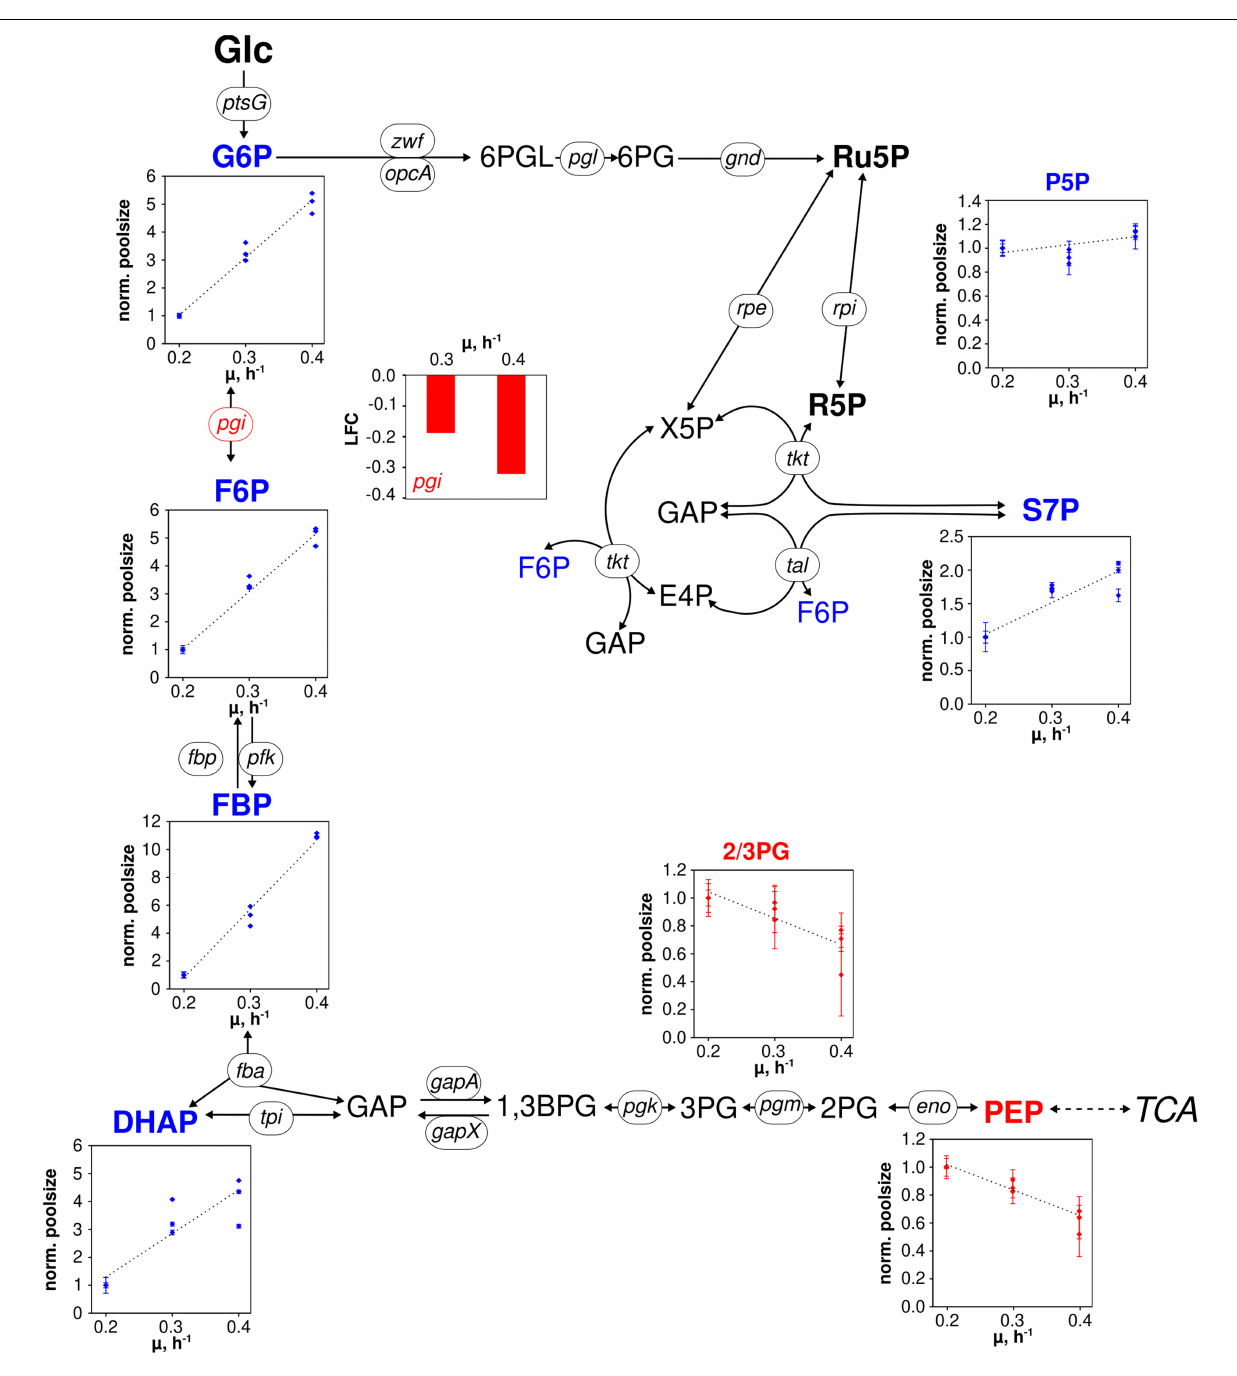
FIGURE 3 | Metabolic and transcriptional response in glycolysis and pentose phosphate pathway of C. glutamicum WT to different growth rates ( µ = 0.2, 0.3, 0.4 h - 1 ) installed in three independent chemostat processes. Depicted intracellular metabolite concentrations were normalized to respective values determined at µ = 0.2 h - 1 ; values represent the mean of three technical replicates ± standard deviation. Gene expression was normalized to the expression level determined at µ = 0.2 h - 1 and is depicted as log fold change (LFC); genes are shown in italic writing. Color code: red, decreasing concentration/expression; blue, increasing